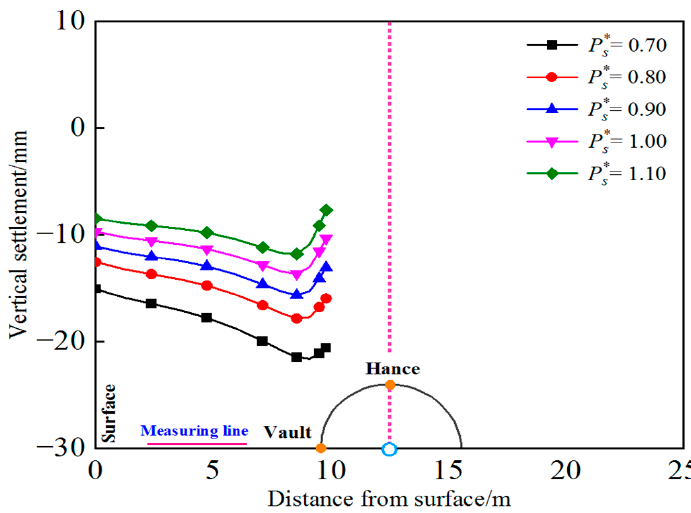
Figure 14. Vertical deformation of the stratum under different support pressure ratios P ∗ s